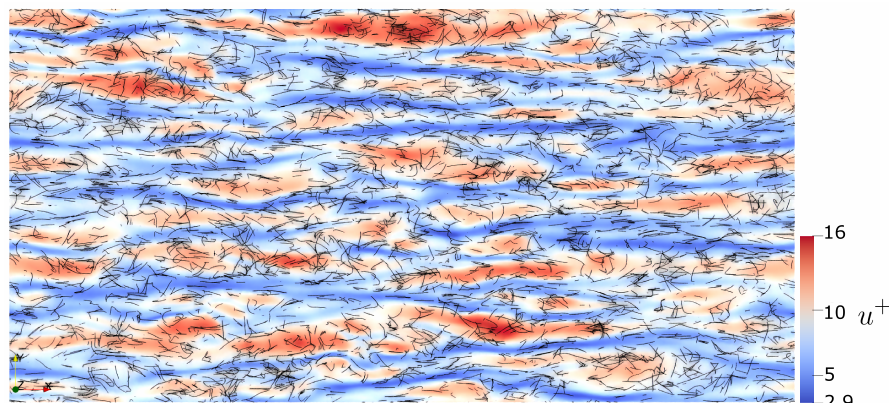
Figure 10. Top view of the streamwise fluid velocity streaks in the near-wall region ( z + = 10) and instantaneous fiber distribution. Reference simulation: St + n = 0.01, ρ p